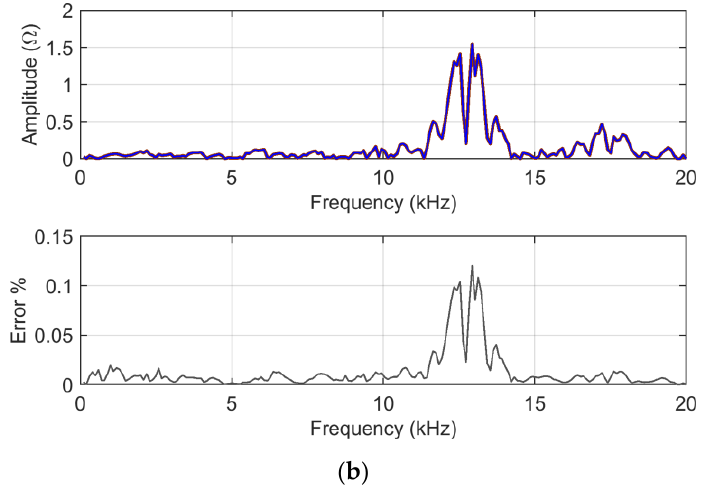
Figure 2. Z (45.0 km) and Z (45.5 km) input data in linear scale: ( a ) ADM i and ( b ) FDM i plots as provided by analytical calculation (blue) and by means of MCM output (brown); blue and brown curves are overlapped with underlying brown curve visible at the edges of the blue one. The relative error remains below 0.15% in all cases, demonstrating the reliability of MCM simulations and lack of biasing.